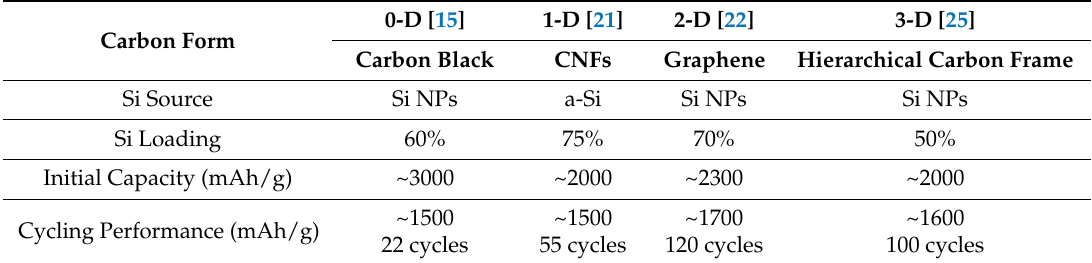
Table 1. Selected examples of Si anode with different carbon forms.